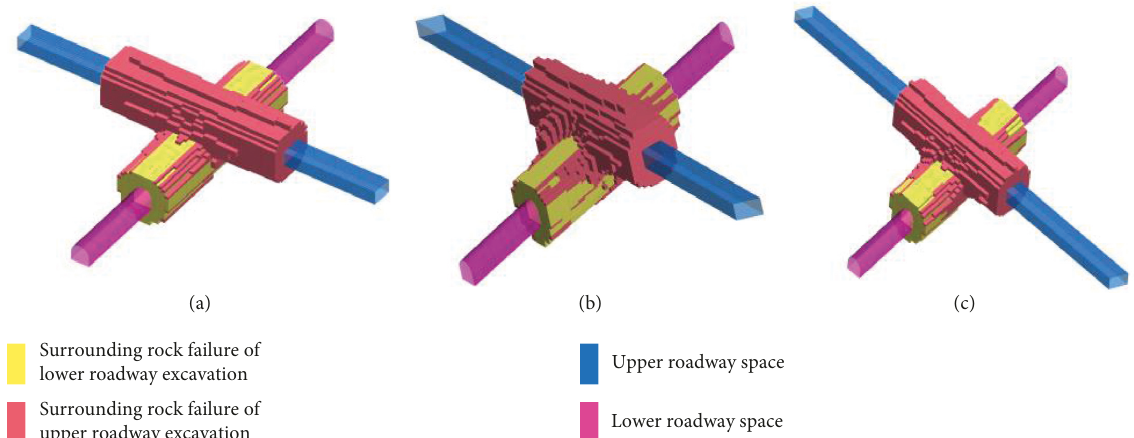
Figure 8: Disturbance influence of distance between roadways on surrounding rock failure of staggered roadways. (a) 90 ° horizontal azimuth angle of staggered roadways, (b) 60 ° horizontal azimuth angle of staggered roadways, and (c) 30 ° horizontal azimuth angle of staggered